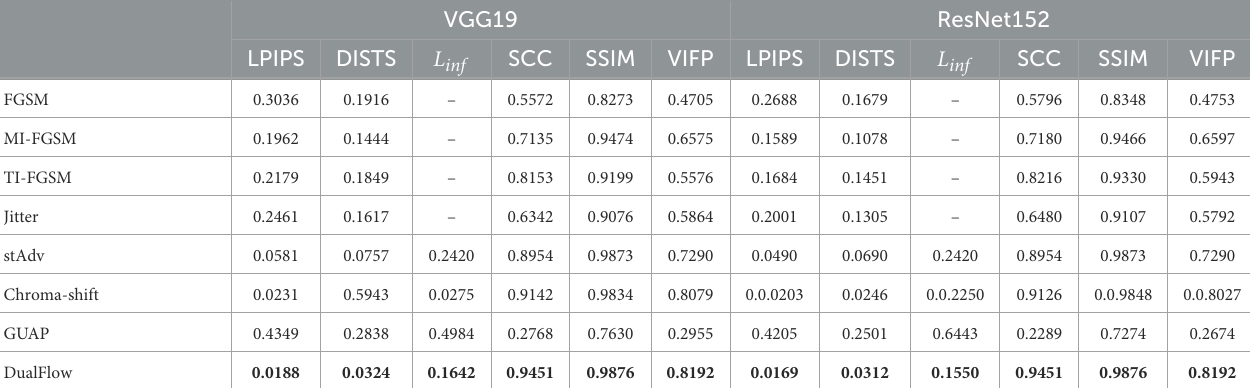
TABLE 6 Perceptual distances were calculated on fooled examples by FGSM, MI-FGSM, TI-FGSM, Jitter, stAdv, Chroma-shift, GUAP, and the proposed DualFlow on